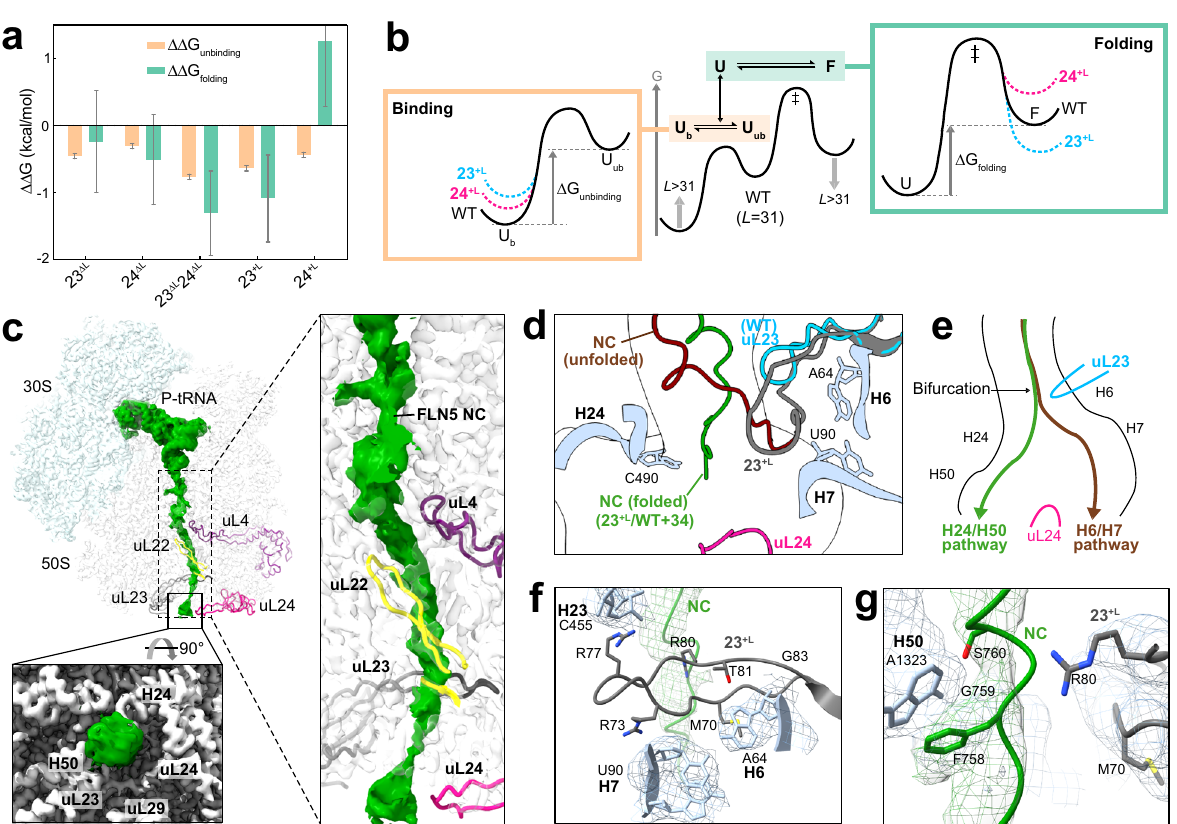
Fig. 5 Modulation of NC binding and folding by uL23 and uL24 loop extension. a Comparison of folding and unbinding free energies of WT and mutant RNCs ( L = 31). The free energies and their errors are from Fig. 2e and Supplementary Fig. 10b. b Binding and folding free energy landscapes of FLN5 on the WT and mutant ribosomes from a . U b and U ub indicate the bound and unbound unfolded NC on the ribosome. c – g Cryo-EM structure of the 23 + L RNCs ( L = 34). c Cryo-EM reconstruction of the 23 + L RNC. The tRNA and the NC cryo-EM density extending from the PTC through the exit tunnel is shown in green. The inset below is a view from the bottom (90° rotation) that shows the additional density corresponding to the globular domain of FLN5. The inset on the right is a close-up view of the NC density inside the exit tunnel around four ribosomal proteins. d Overview of the extended uL23 loop structure (grey) and its interaction with 23S rRNA and FLN5 NC (green). Unmodi fi ed uL23 loop (cyan) and FLN5 NC ( L = 47) on the WT ribosome (brown) are shown in comparison. The schematic tunnel wall is shown in black lines and the 23S rRNA is shown in light blue. e Two different exit pathways of FLN5 NCs in the vestibule, bifurcated by the uL23 loop 36 . f Interactions between the extended uL23 loop residues and 23S rRNA. g Isolated cryo-EM density (green mesh) and molecular model (green cartoon) of the NC with the interacting segments from H50 and extended uL23